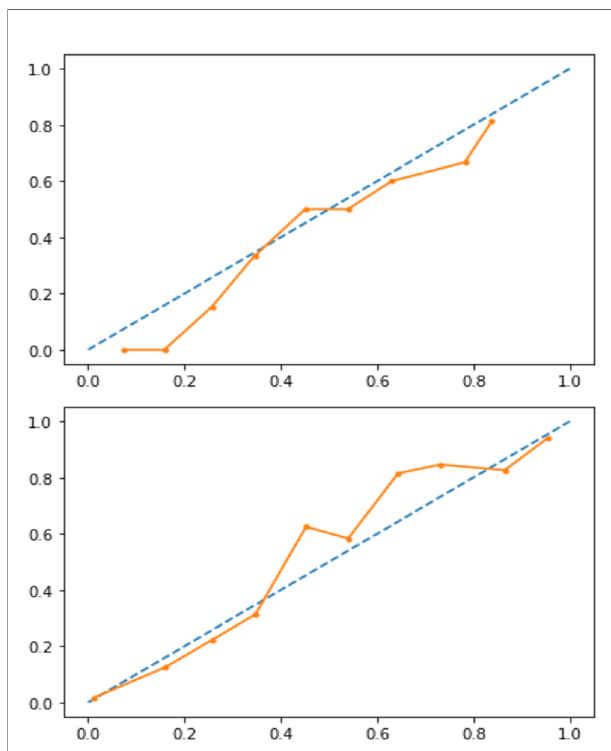
FIGURE 4 | Calibration curve before (upper panel) and after (lower panel) isotonic calibration. After calibration, GCA fl are roughly happened with an observed relative frequency (dotted line) consistent with the forecast value (solid orange line), showing an acceptable